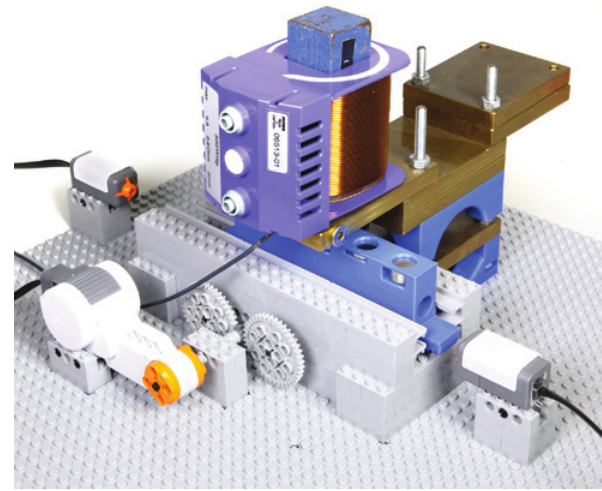
Figure 3: Photograph of the experimental configuration consisting of microscope and sample unit of the macroscopic acoustic MFM